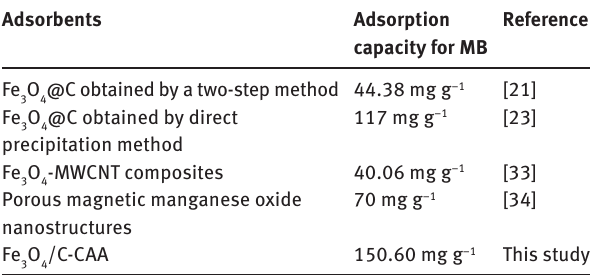
Table 3: Comparison of adsorption ability with different adsorbents.